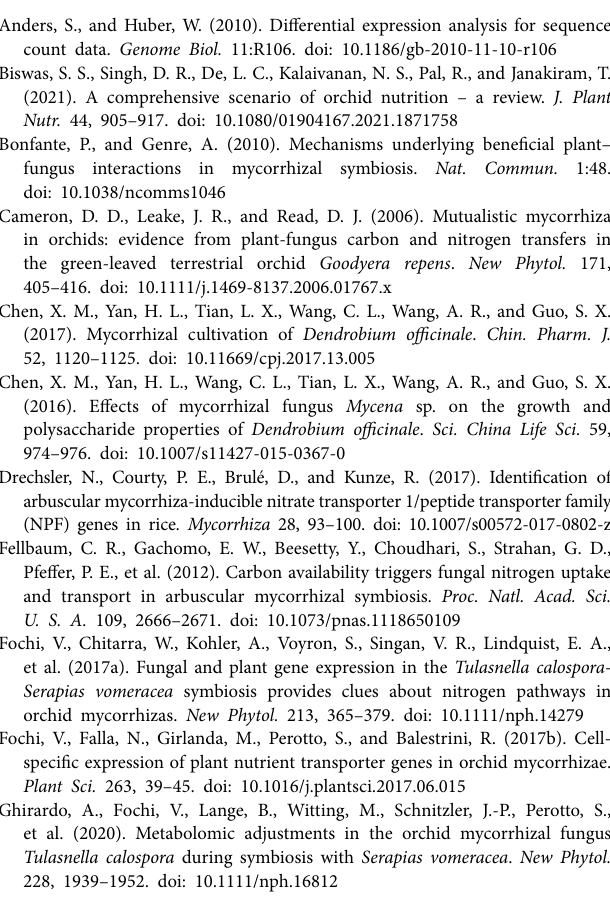
Supplementary Figure S1 | GO classification of DEGs. Supplementary Figure S2 | KEGG enrichment analysis of DEGs. Supplementary Figure S3 | Principal component analysis (PCA) of conventional and mycorrhizal cultivation of Dendrobium officinale . Supplementary Figure S4 | KEGG enrichment analysis of DEMs. Supplementary Figure S5 | KEGG pathway for N metabolism from the transcriptome and metabolome. Supplementary Figure S6 | Growth conditions of samples for validation.